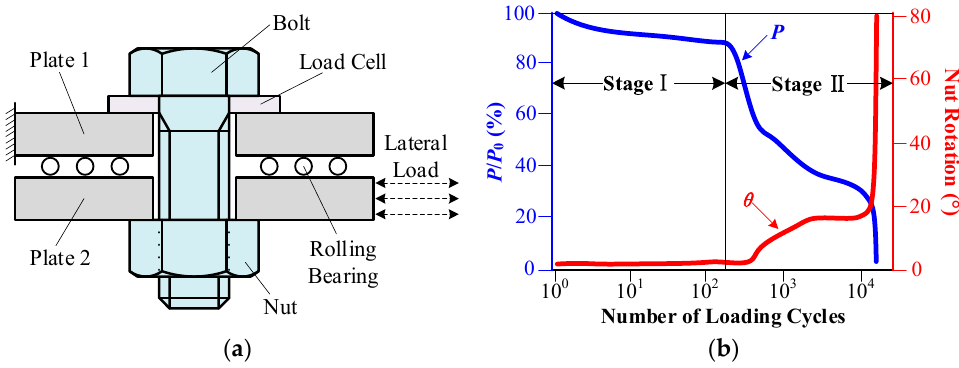
Figure 1. Experiment of bolt loosening: ( a ) experimental equipment of bolt loosening; ( b ) curve of bolt loosening.